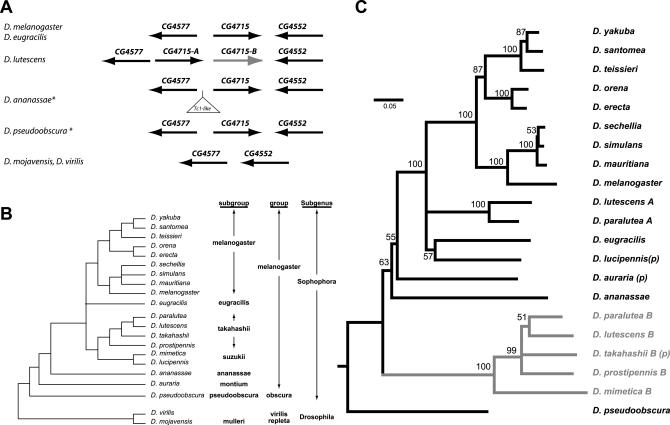
Phylogenetic Analysis of CG4715 Homologs(A) CG4715 has been preserved in its syntenic location in Drosophila species. In species from the takahashii/suzukii species groups like D. lutescens, an additional paralog, CG4715-B (gray shading) is found in tandem orientation. D. ananassae has an additional transposon insertion in this syntenic location between CG4715 and CG4552, while the genomes of D. mojavensis and D. virilis lack CG4715 orthologs between CG4577 and CG4552. For D. ananassae and D. pseudoobscura, sequence was obtained from genome sequencing data (indicated with an asterisk) and confirmed by sequencing.(B) An “expected” phylogeny of Drosophila species is shown, summarizing results from many genes [30,31].(C) A neighbor-joining phylogeny of CG4715 orthologs based on C-terminal amino acid sequence is presented. (For some species, only the C-terminal sequence was obtained (indicated by a “p” for partial)). This phylogeny is largely in agreement with the accepted species phylogeny in (B), indicating that the gene has been inherited by strict vertical inheritance. Although there is a slight discordance in phylogenetic placement of the D. ananassae, D. eugracilis, and D. auraria, these branches have only a low bootstrap support. A second lineage of CG4715 paralogs, CG4715-B is evident (gray shading) in the takahashii/suzukii species groups.